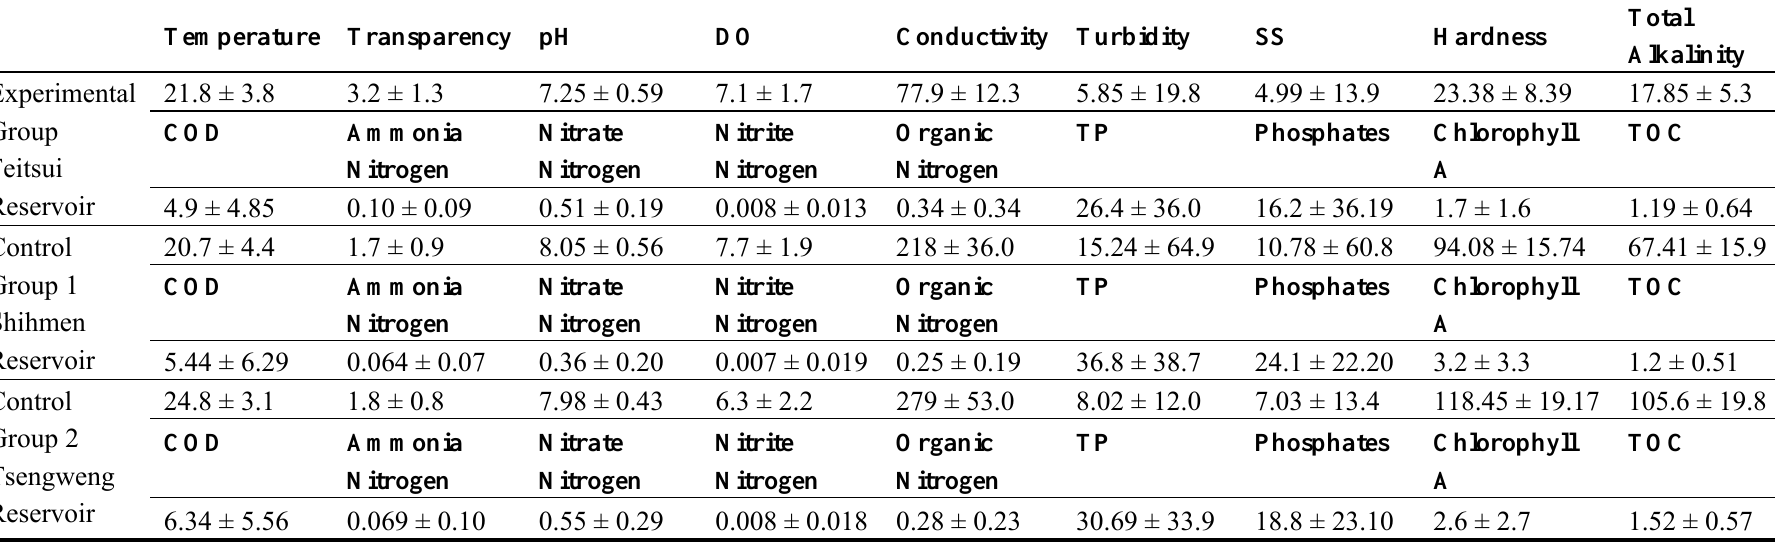
Table 2. Basic statistical analysis of reservoir water